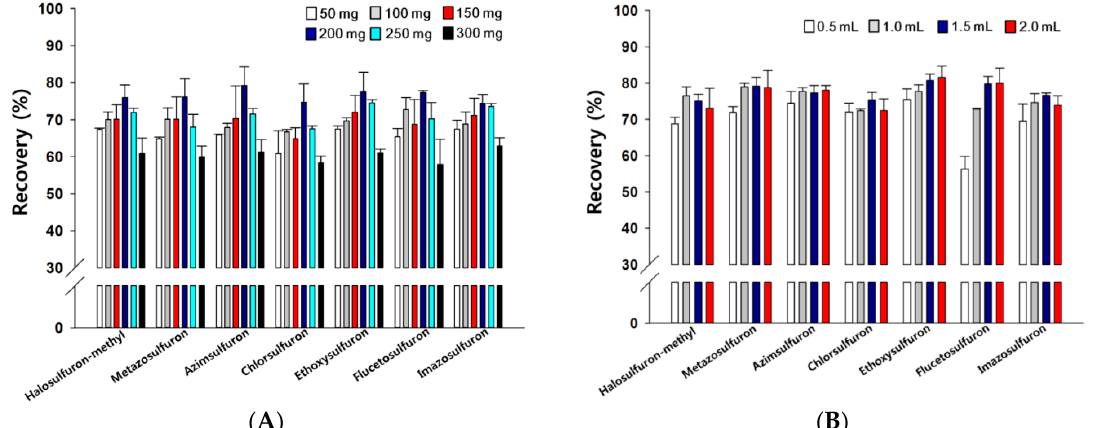
Figure 1. Recoveries as functions of ( A ) the amount of added C 18 and ( B ) the volume of added water for selected sulfonylurea herbicides in strawberries fortified at 0.05 mg/kg using the dispersive solid–liquid extraction (d-SLE) method. In ( A ), 1.0 mL of water was added to facilitate the adsorption of the analytes in acetonitrile onto the C 18 . In ( B ), 200 mg of C 18 was used to adsorb the target herbicides.